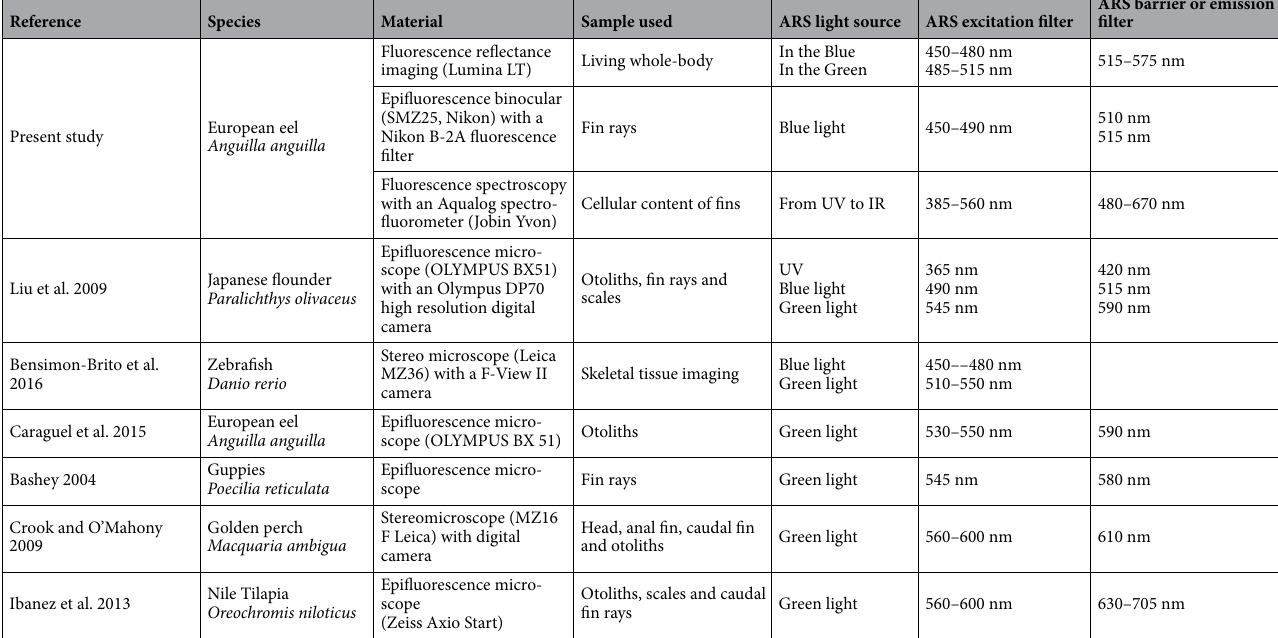
Table 3. Studies of interest that analysed alizarin red S stains other than on otoliths. Literature reference, species names, material, sample used, light source and filter used to detect alizarin (ARS) are presented for each